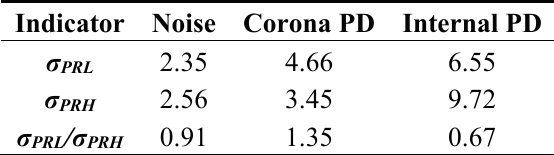
Table 6. Results obtained of the standard deviation for each cluster associated with PD and